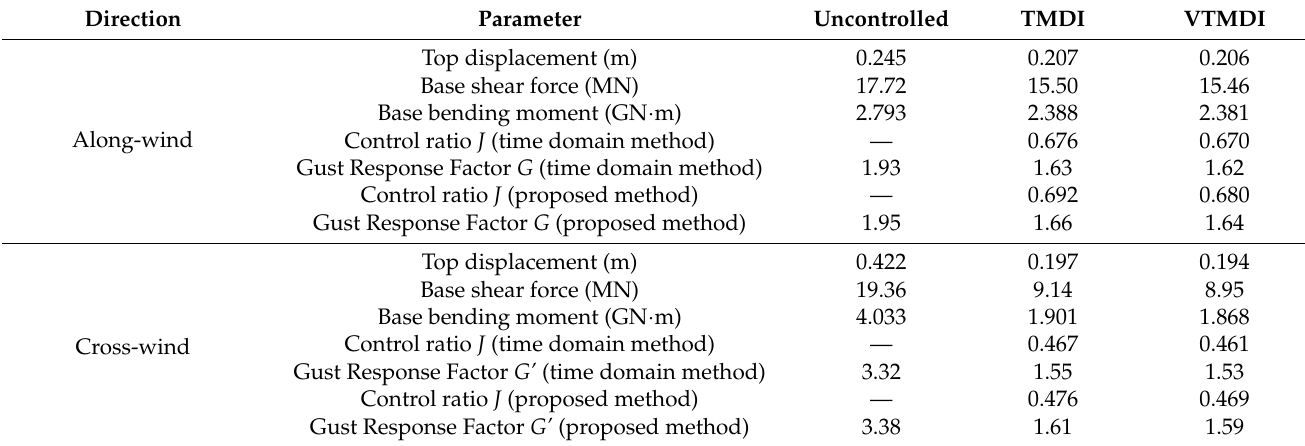
Table 8. Peak wind-induced responses, control ratios, and gust response factors for the cases.